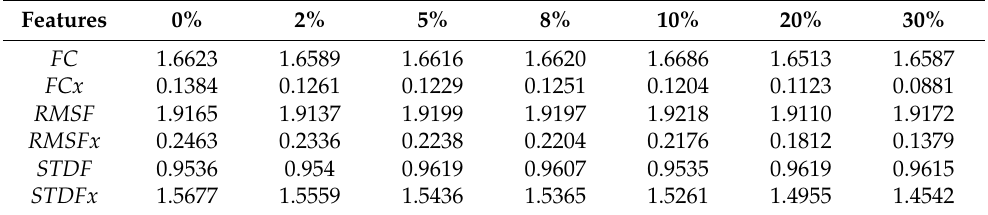
Table 3. Comparison of feature extraction effect between improved method and traditional method.